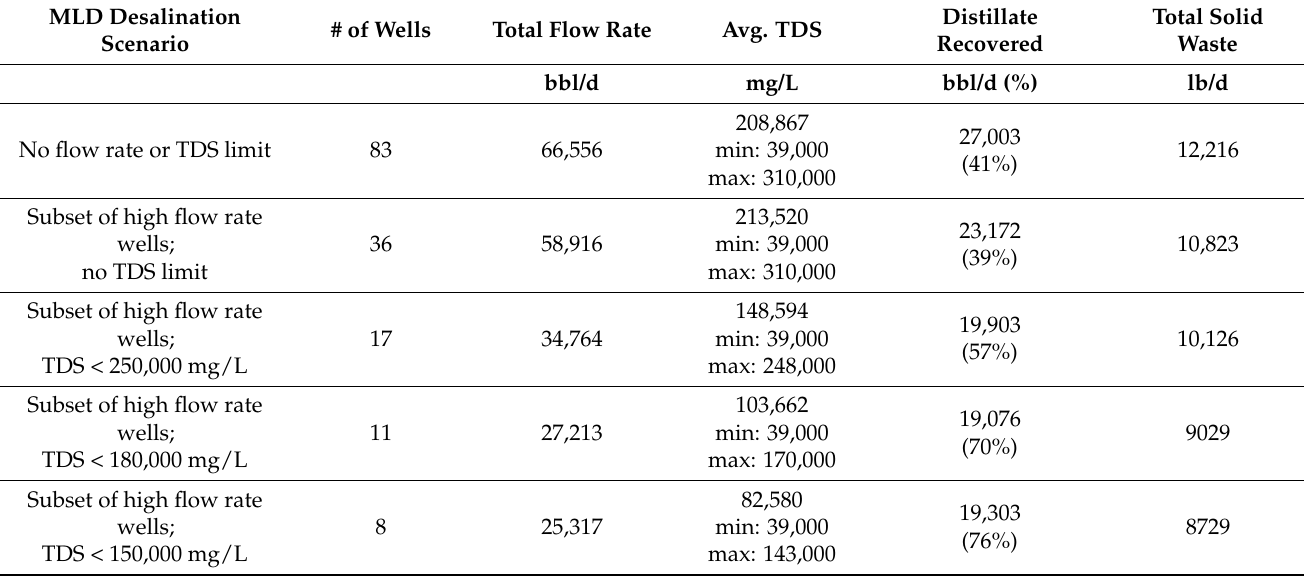
Table 2. Utilizing a selective MLD approach to optimize distillate